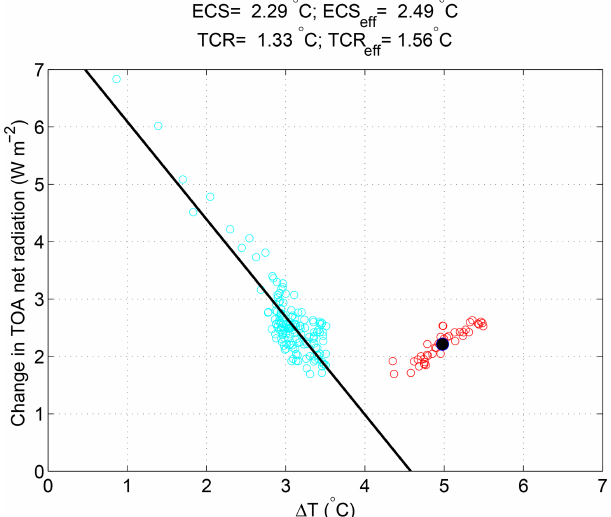
Figure 16. Estimation of ECS and effective ECS (ECS eff ) in NorESM1-F. Blue dots are simulated change of TOA radiation flux (cid:49)R (Wm − 2 ) versus the change of global mean surface air temper- ature (cid:49)T ( ◦ C) in the abrupt 4 × CO 2 experiment; the black line is the linear regression of the two variables. Red dots denote the effec- tive temperature response in the last 40 years of the abrupt 4 × CO 2 experiment, and the black dot is the average (see text for further